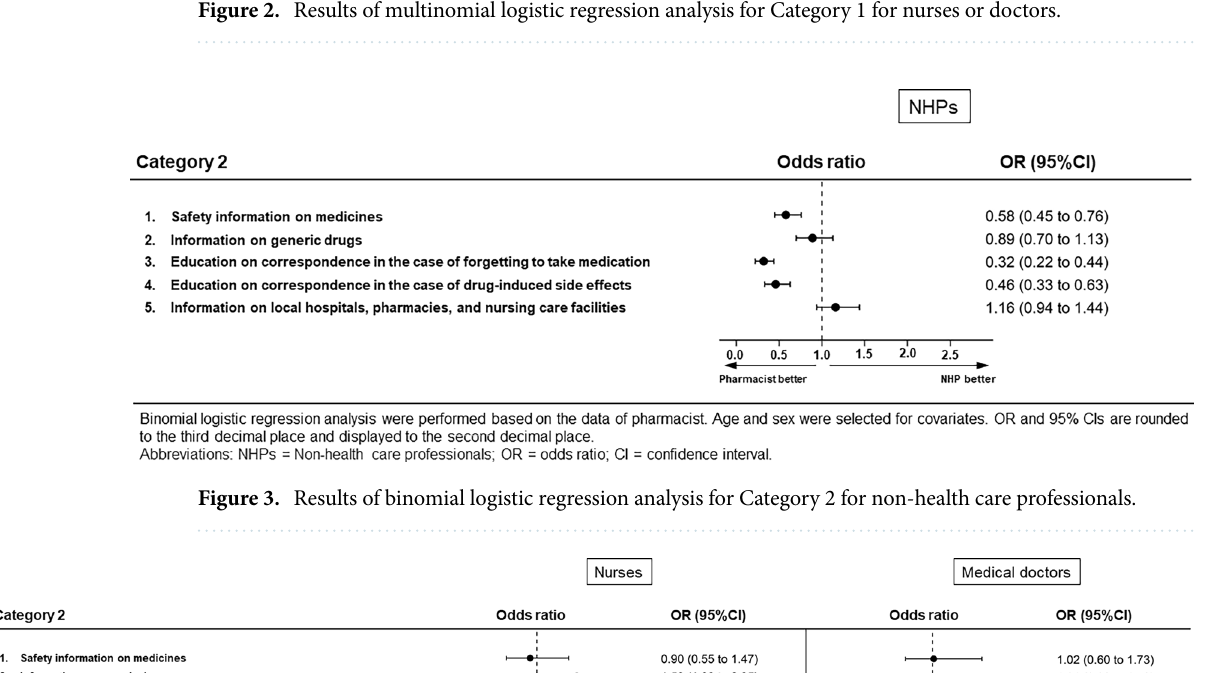
Figure 2. Results of multinomial logistic regression analysis for Category 1 for nurses or doctors.